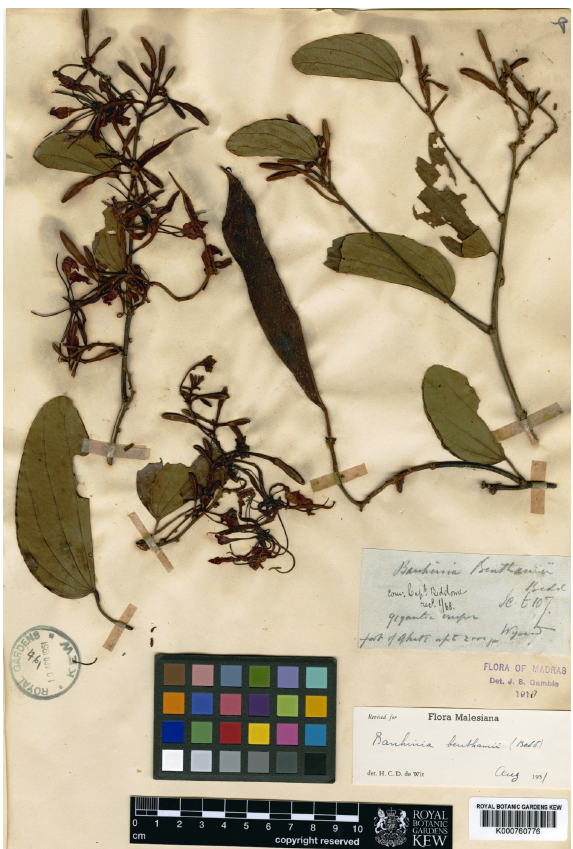
Image 8. Lectotype of Bauhinia benthamii (K-000760776, © the Board of Trustees of the Royal Botanic Gardens, Kew).